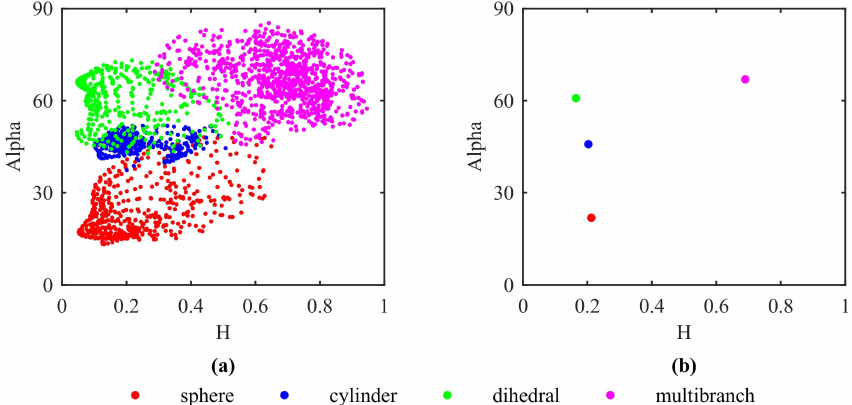
Figure 11. Particle swarm optimization (PSO) for H-Alpha data. ( a ) Training H-Alpha data before PSO. ( b ) Sample centers after PSO iteration.